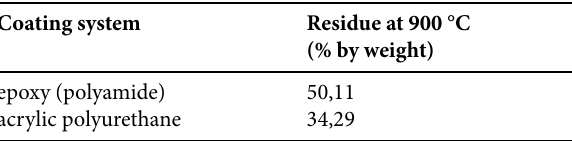
Table 2. Residual weight loss percentage of coating systems by ther- mogravimetric analysis Coating